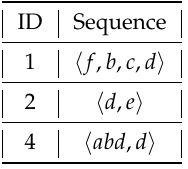
Figure 4. Projected database for prefix (cid:104) a , b , c (cid:105)